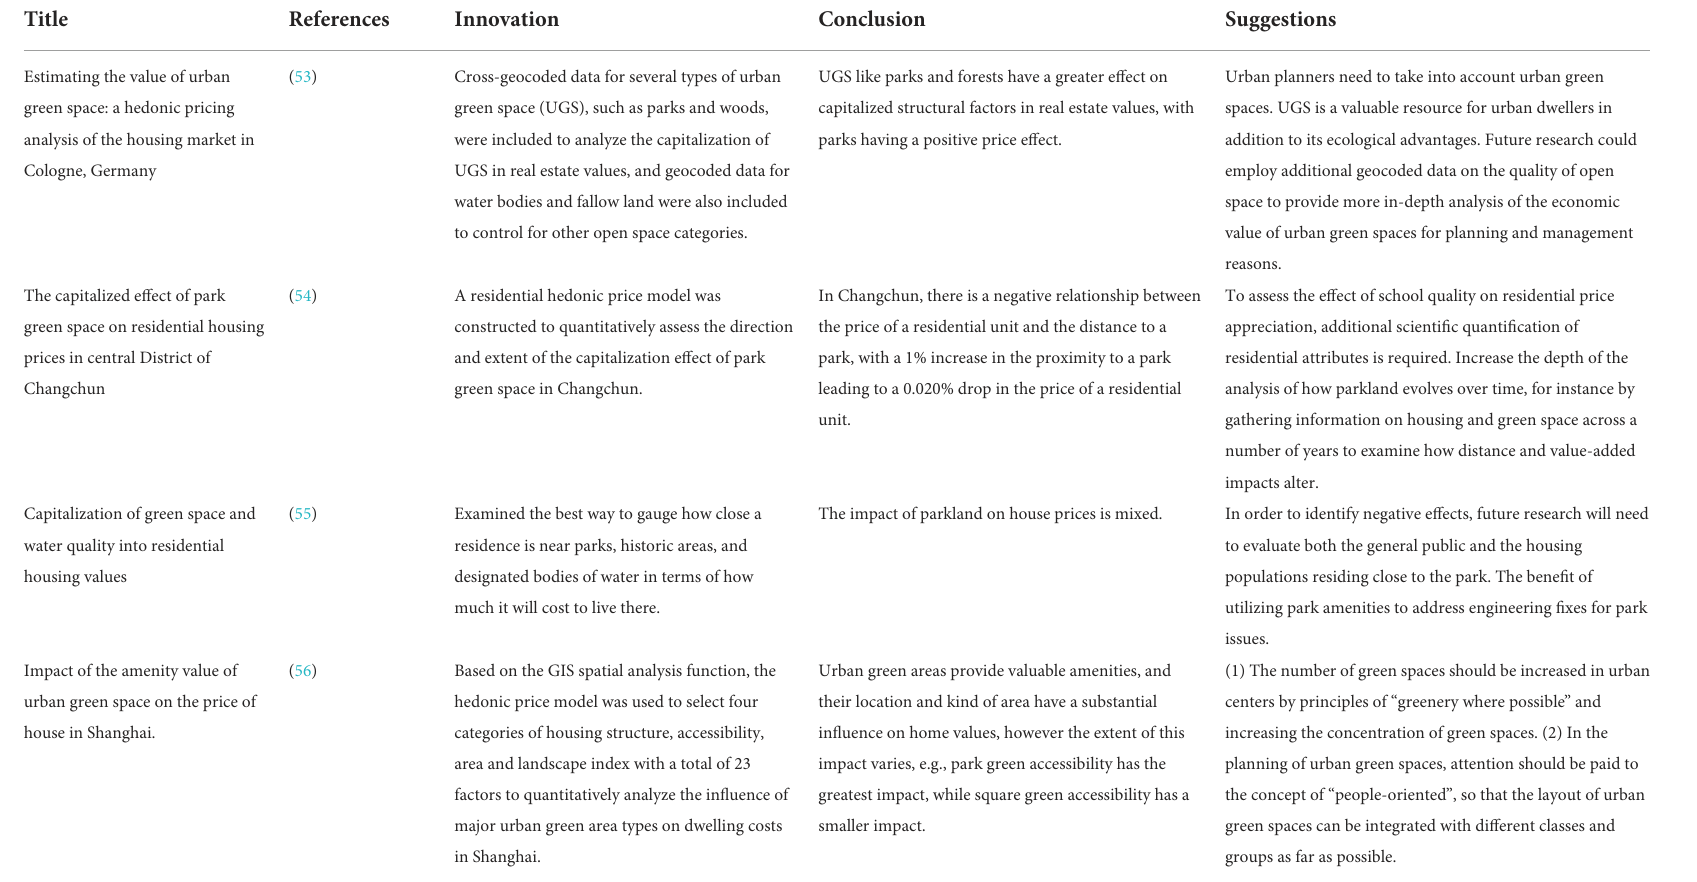
TABLE 7 Literature review on the context of diverse